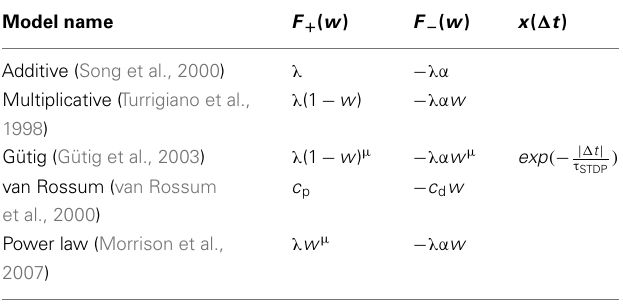
Table 1 |Weight- and spike-timing-dependence of pair-based STDP models: additive, multiplicative, Gütig, van Rossum, and power law